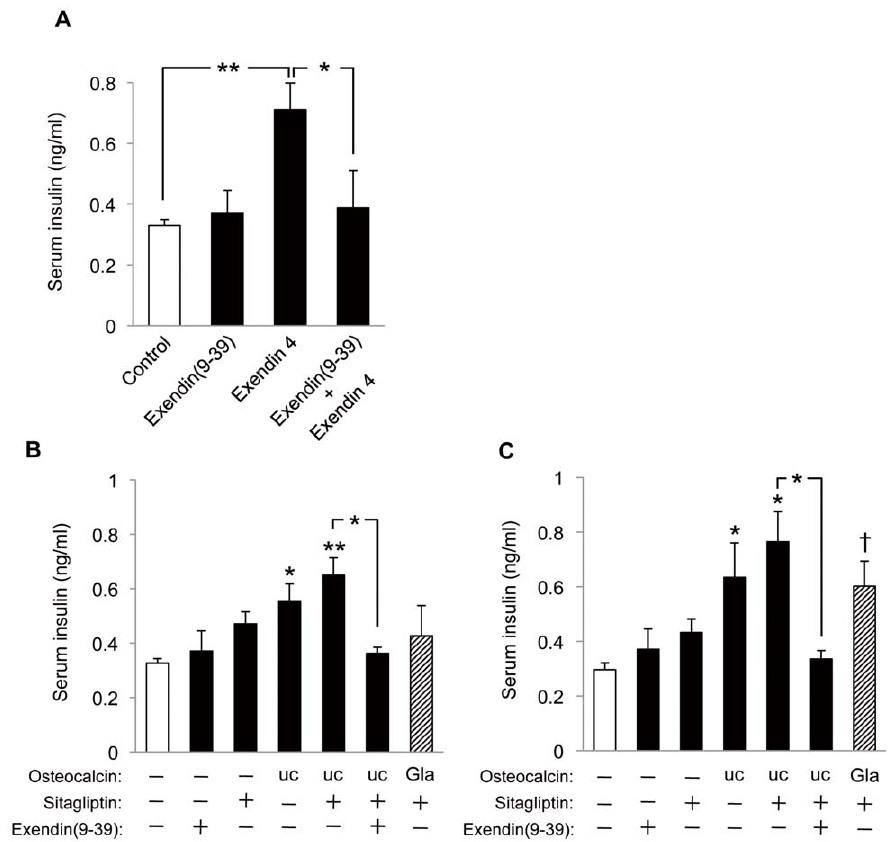
Figure 4. Effects of the GLP-1 receptor antagonist exendin(9 – 39) on insulin secretion induced by OC. ( A ) Mice deprived of food for 5 h (blood glucose level, 103.5 mg/dl) were injected intraperitoneally with saline or exendin-4 (25 nmol/kg) at 30 min after intraperitoneal injection with saline or exendin(9–39) (25 nmol/kg). Blood samples were collected 20 min after exendin-4 injection for determination of the serum insulin concentration. ( B , C ) Mice deprived of food for 5 h (blood glucose level, 103.5 mg/dl) were administered sitagliptin (1 m g/kg) or saline orally and then 30 min later were treated with ucOC or GlaOC intraperitoneally (7 m g/kg) ( B ) or orally (10 m g/kg) ( C ) in combination with intraperitoneal injection of exendin(9–39) (25 nmol/kg) or saline. Blood samples were collected 20 min after OC administration for assay of serum insulin. All data are means 6 SEM for four to six mice. * P , 0.05, ** P , 0.01, { P = 0.06 versus control (open bar) or for the indicated comparisons (Student’s t test).